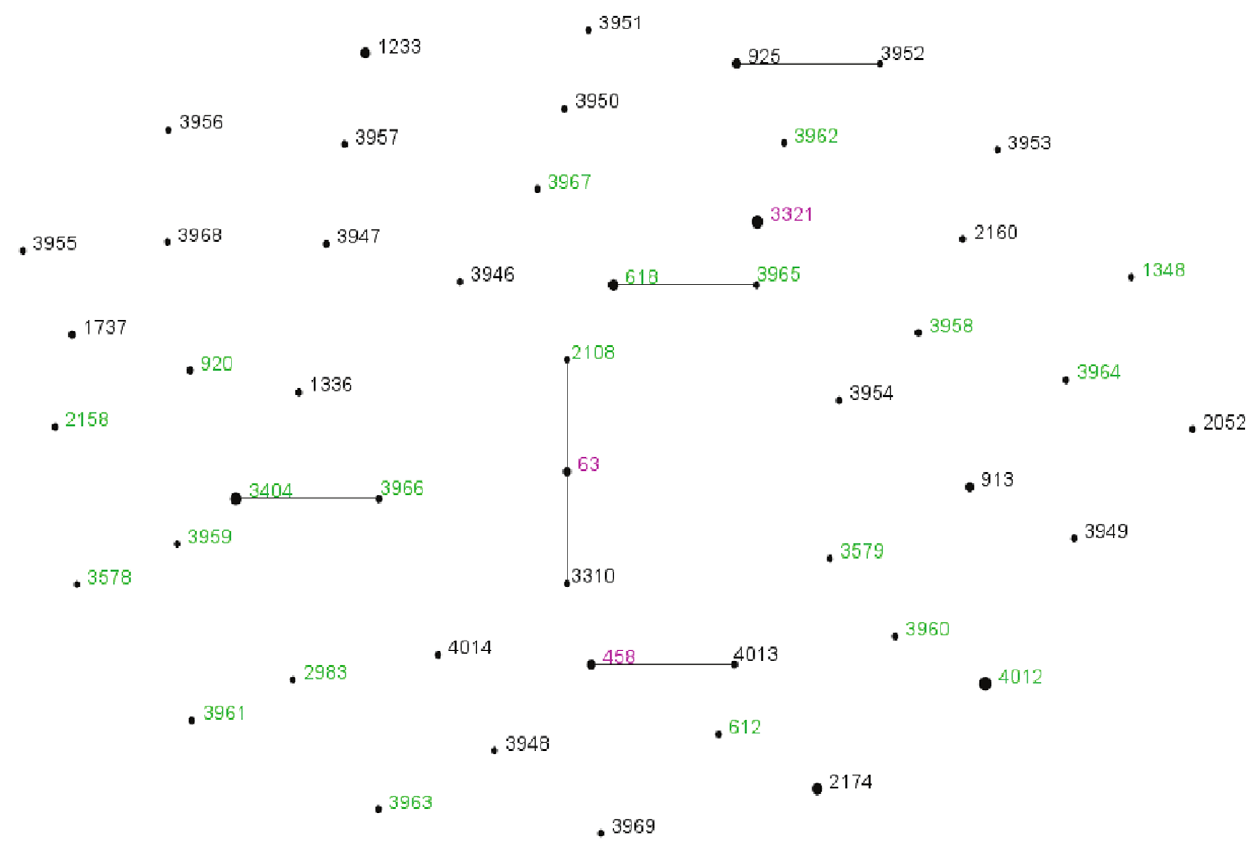
Figure 1. eBURST analysis of the S. pneumoniae study isolates. Each ST is represented by a point, the size of which is determined by the number of isolates with that ST in the combined data set. STs differing at a single genetic locus are linked by a straight line.